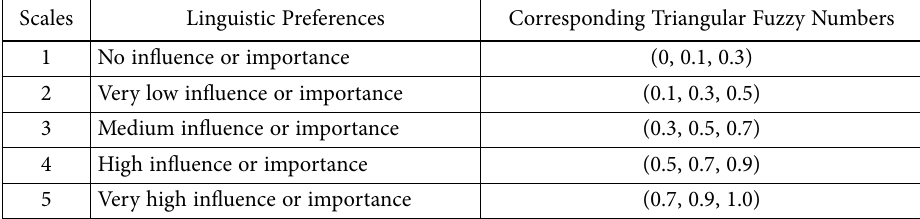
Table 2. Linguistic Scales for Corresponding TFNs proposed by Wu et al. (2015) Scales Linguistic Preferences Corresponding Triangular Fuzzy